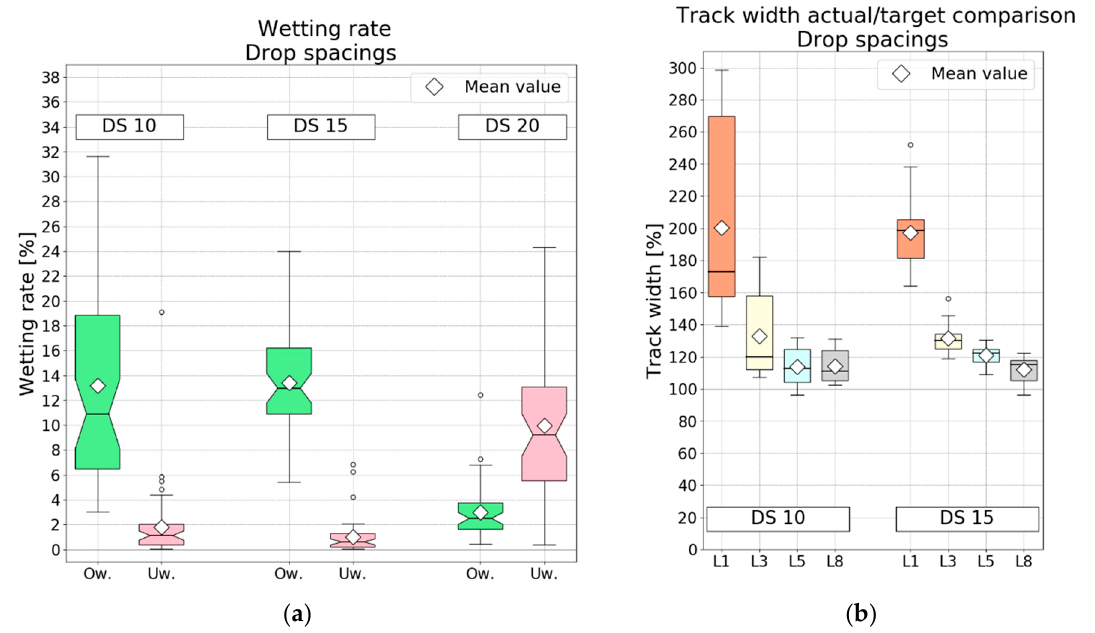
Figure 10. Boxplot diagrams of ( a ) Wetting rates, including overwetting and underwetting and ( b ) track width actual/target comparison for different line widths by varied drop spacings.